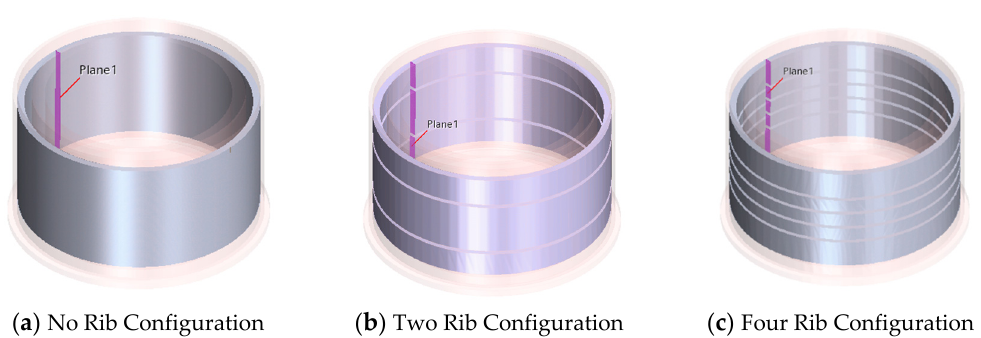
Figure 6. Plane section location to monitor the phase change.